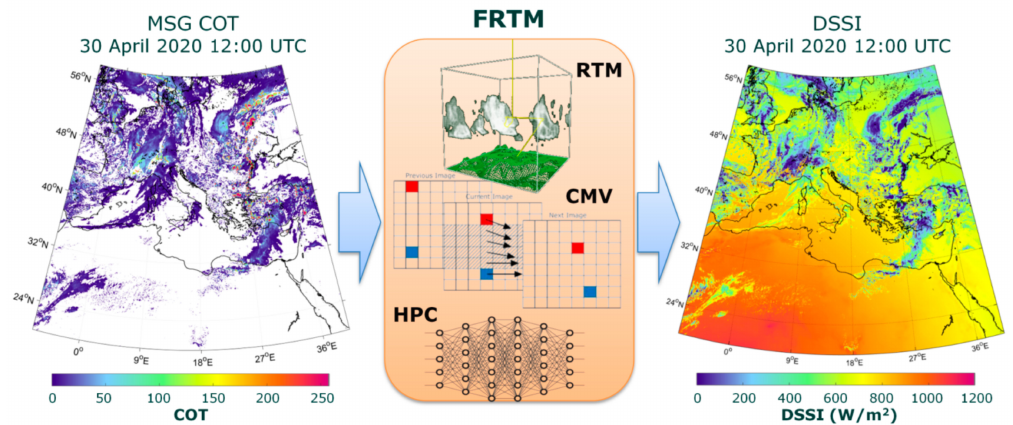
Figure 4. Flowchart illustration of the FRTM modeling techniques